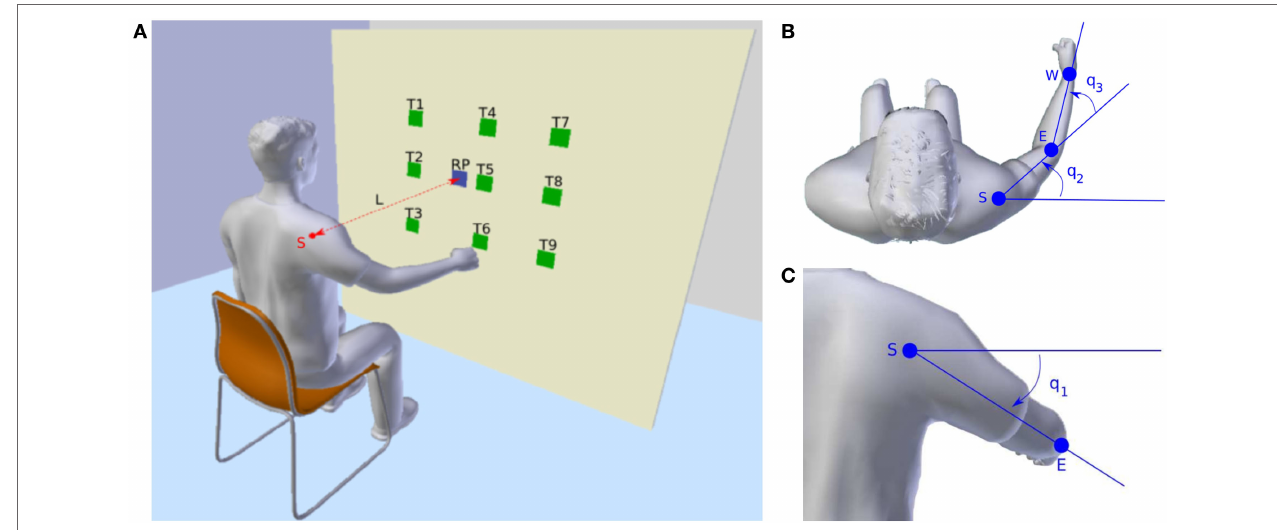
FIGURE 2 | Experimental setup. (A) Overview of the experimental setup. T1 to T9 denote the nine target areas. RP means the reference point used to adjust the sitting position of the subject. S is the center of the shoulder joint and L is the distance between S and RP which is defined as 80% of the subject’s arm length. (B) Top view of the subject. S, E, and W are the shoulder joint, the elbow joint, and the wrist joint, respectively. As in the arm model defined, q 2 and q 3 are the yaw rotation of the shoulder joint and the pitch rotation of the elbow joint. (C) Back view of the subject. q 1 is the pitch rotation of the shoulder